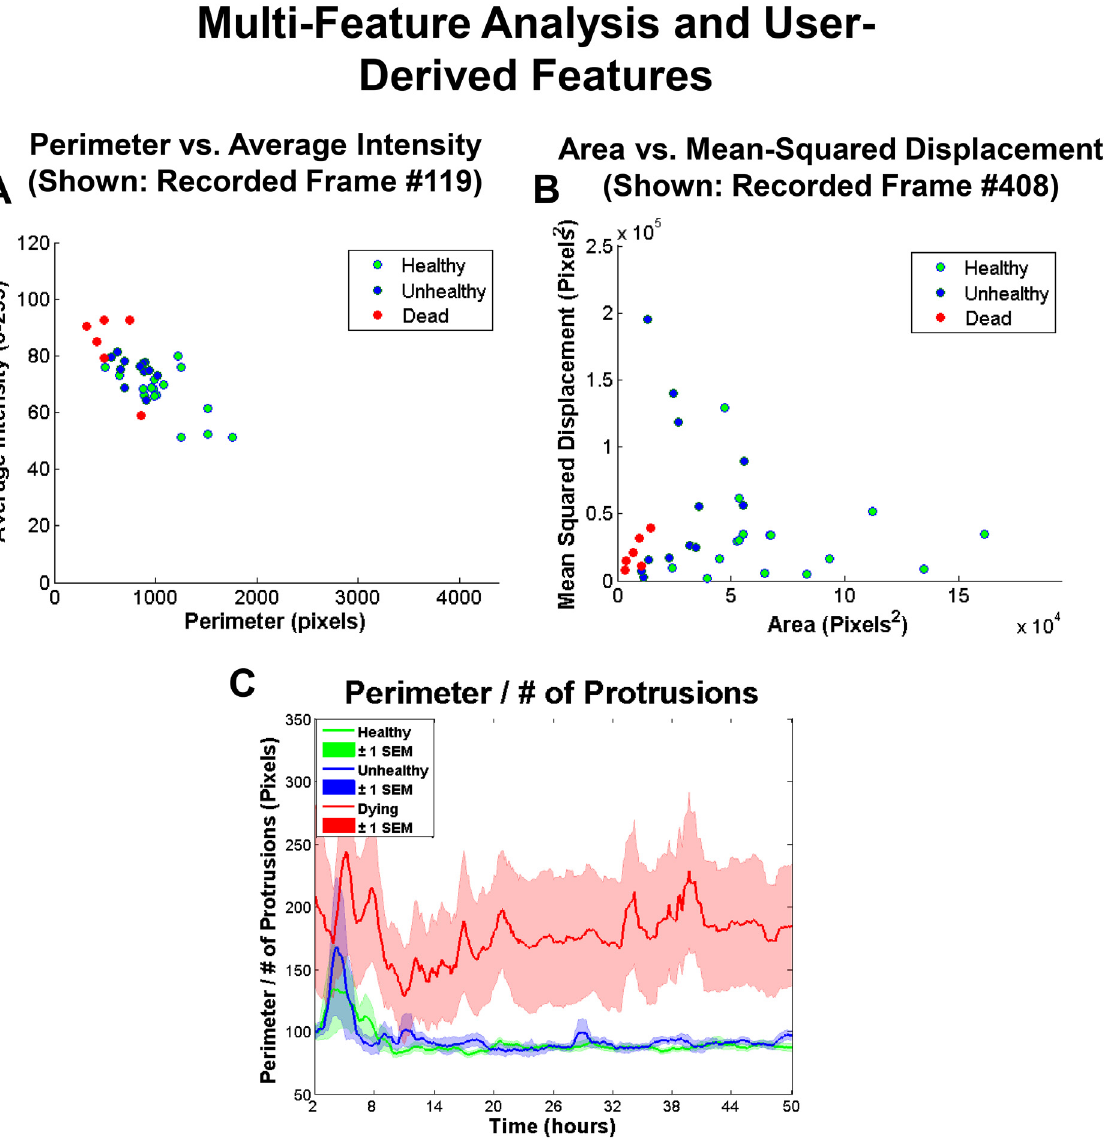
Fig 5. Two-Feature Plot Analysis. (A) Average intensity compared to perimeter running plot shown at approximately at 16 hours of incubation for all individual healthy (green), unhealthy (blue), and dying (red) hESC colonies. (B) Mean-squared displacement compared to area running plot shown at approximately 16 hours for all individual healthy (green), unhealthy (blue), and dying (red) hESC colonies. (C) User derived equation (perimeter divided by number of protrusions) plotted for healthy, unhealthy, and dying